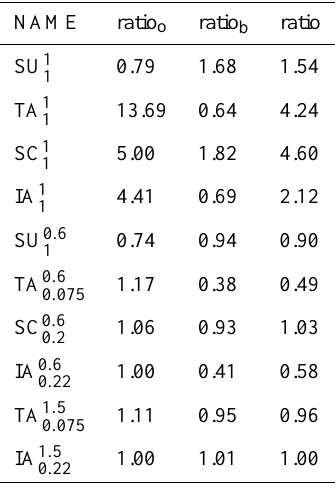
Table 4. Ratios (unitless) of the observation (ratio o ), prior (ratio b ) and full (ratio) variances inferred from the diagnostics presented in Sect. 2.3. These quantities are respectively defined as the ratios be- tween prescribed (var o , var b and var = var o + var b ) and associated diagnosed (diag o , diag b and diag) error variances and represent the goodness of the error statistics in the inversion system. Good statis- tical consistency is obtained when the ratios are close to